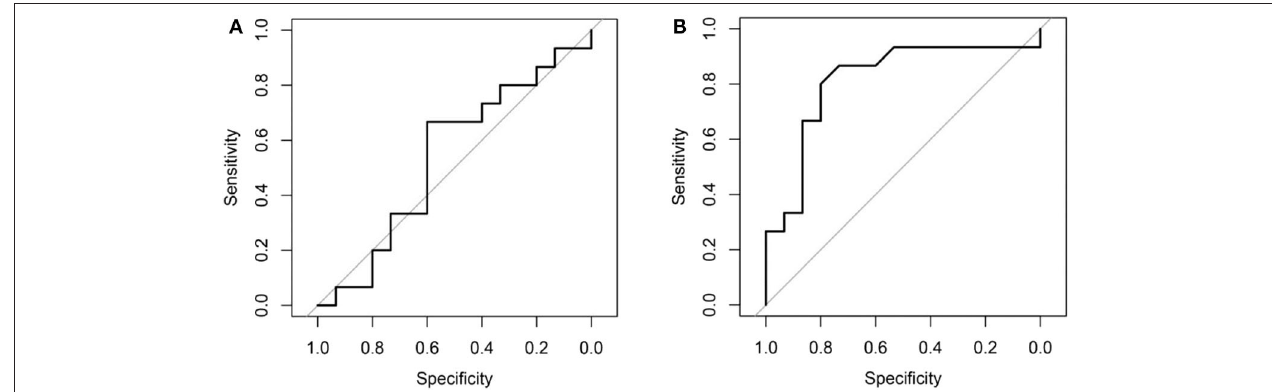
FIGURE 4 | (A) ROC curve for the test cohort for PyRadiomics model (AUC = 0.54). (B) ROC curve for the test cohort for Transfer Learning (LungTrans) model (AUC = 0.81).